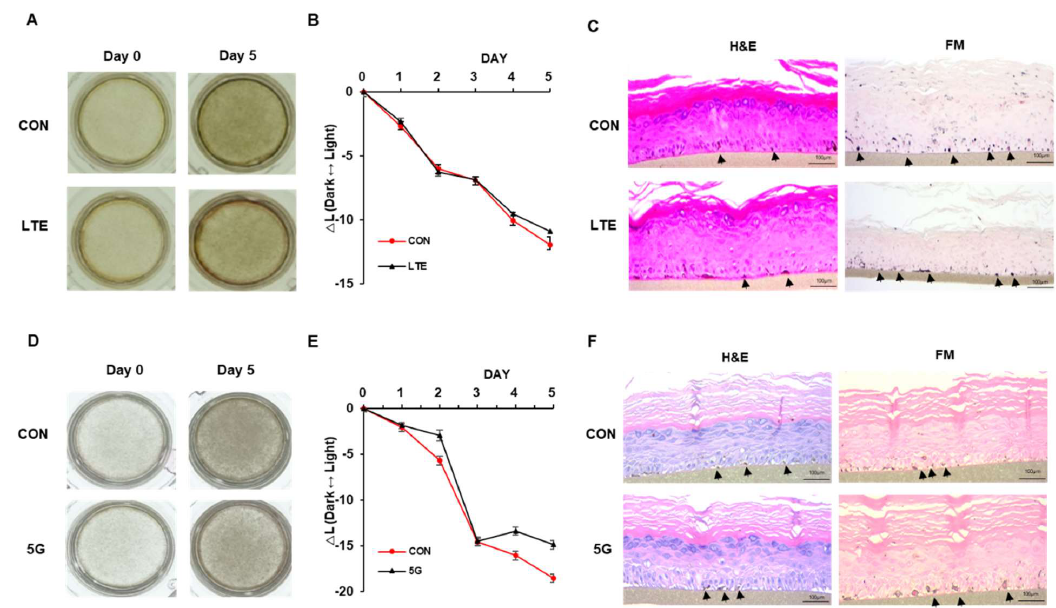
Figure 5. Effects of EMFs on MelanoDerm™, an artificial pigmented skin model. ( A ) Color of LTE-exposed 3D human skin model (MelanoDerm™; MatTek). ( B ) ΔL value in skin tissue between baseline and 5 days after LTE exposure. ( C ) Hematoxylin and eosin (H&E)- and Fontana–Masson (FM)-stained tissue after LTE exposure. ( D ) Color of 5G-exposed MelanoDerm TM . ( E ) ΔL value in skin tissue between baseline and 5 days after 5G exposure. ( F ) Hematoxylin and eosin (H&E) and Fontana–Masson (FM)-stained tissues after 5G exposure. Black arrow heads indicated the stained melanocytes.